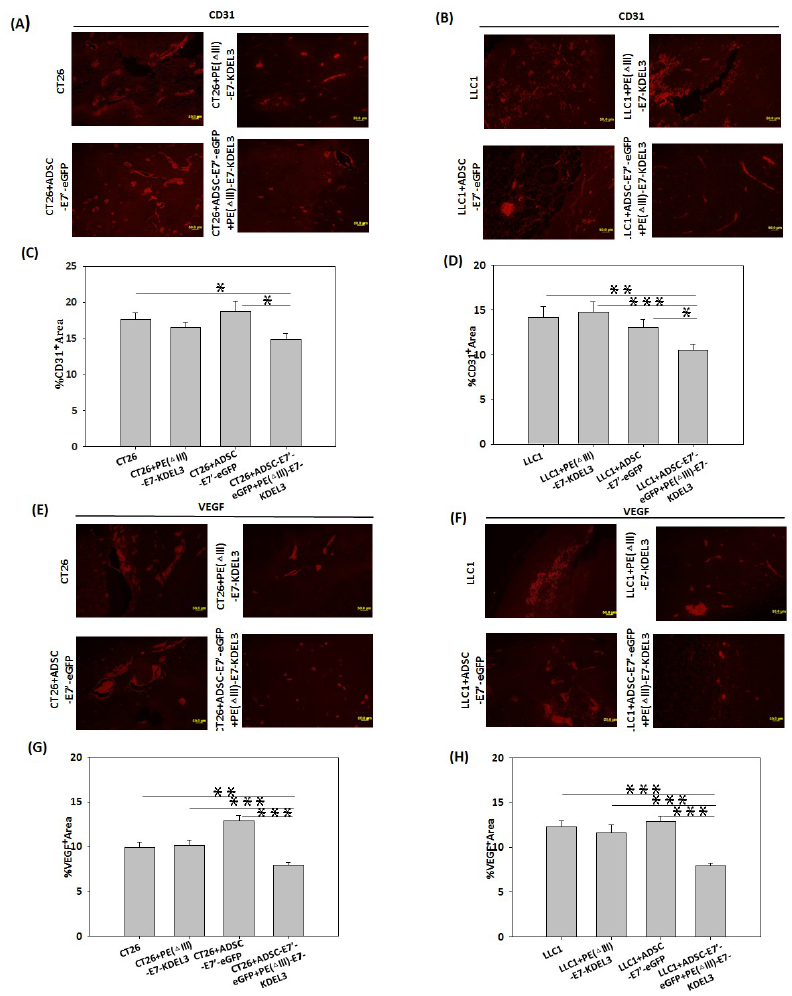
Figure 5. Histological assessment of tumor angiogenesis. Representative fluorescence images of tumor sections from mice inoculated with ( A ) CT26 cells or ( B ) LLC1 cells, which were stained with anti-CD31 (red) after 28 days to detect tumor-associated blood vessels. The quantitative results were determined by the average blood vessel area per microscopic field in tumor sections from mice inoculated with ( C ) CT26 cells or ( D ) LLC1 cells. Values are means + SEM; * p < 0.05; ** p < 0.01, *** p < 0.001 using unpaired t -tests ( n = 3). Representative fluorescence images of tumor sections from mice inoculated with ( E ) CT26 cells or ( F ) LLC1 cells were stained with anti-VEGF (vascular endothelial growth factor) (red) to detect tumor vascularization. The quantitative results were determined by the average VEGF expression area per microscopic field in tumor sections from mice inoculated with ( G ) CT26 cells or ( H ) LLC1 cells. Values are means + SEM; ** p < 0.01, *** p < 0.001 using unpaired t -tests ( n = 3). Magnification A,B,E,F: 50 µ